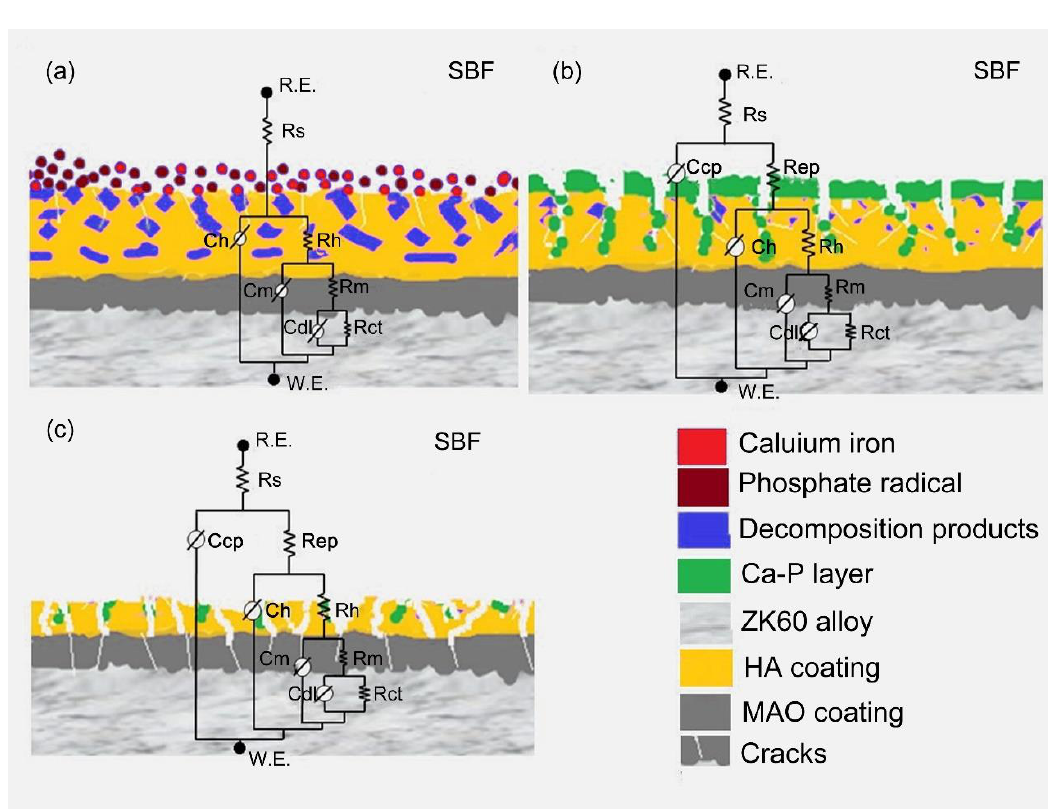
Figure 13. A physical model of the degradation process of MAO/APS samples in the SBF solution with equivalent circuits for fitting the EIS data: ( a ) initial-term of immersion; ( b ) middle-term of immersion; ( c ) late-term immersion.